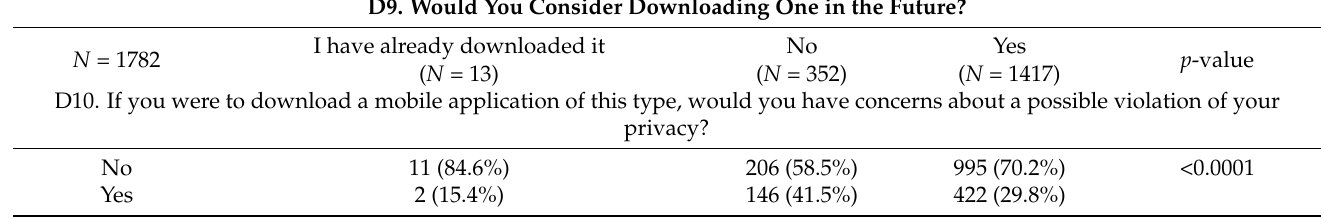
Table 3. Association between the predisposition to download an app against violence against women and concerns in terms of